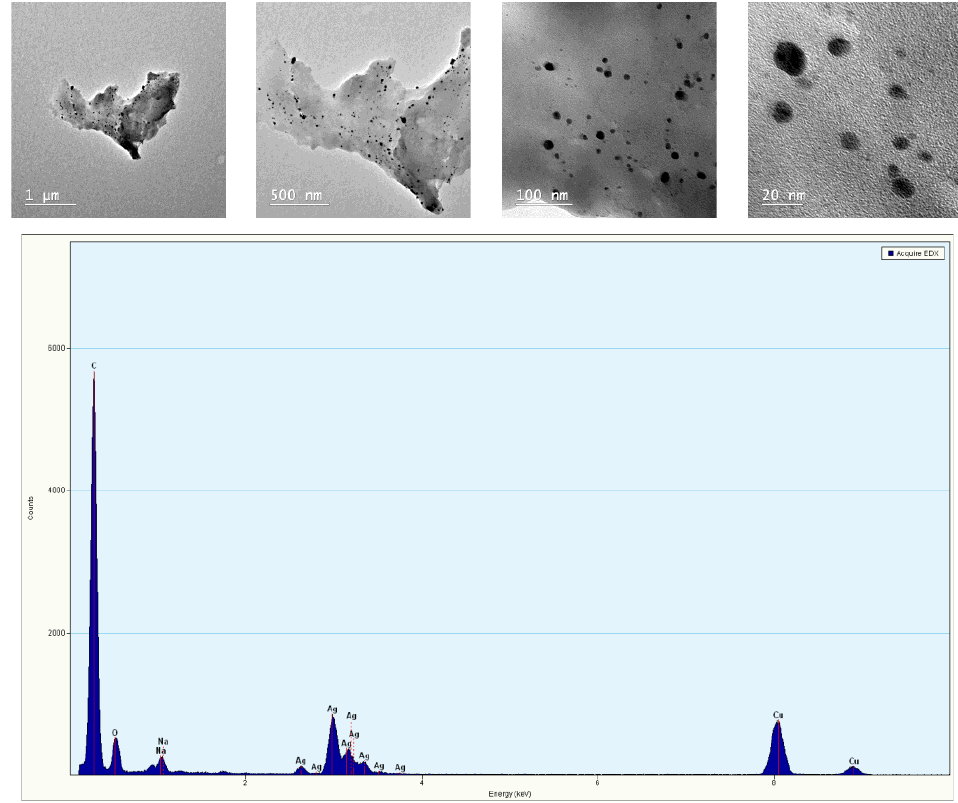
Figure 5. TEM images captured on SA1 sample and EDX spectrum.